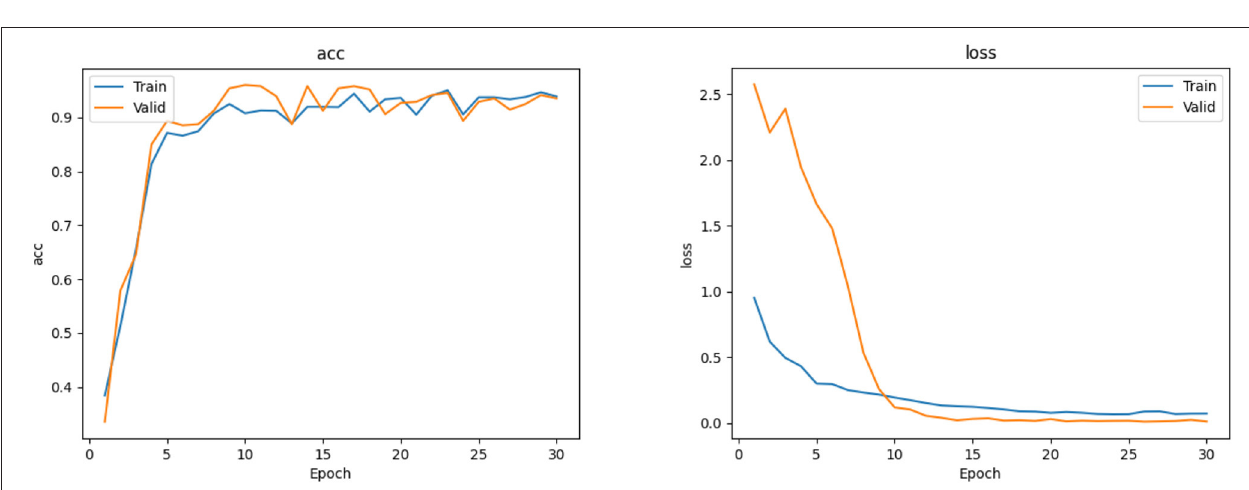
FIGURE 3 | The accuracy and loss curves of